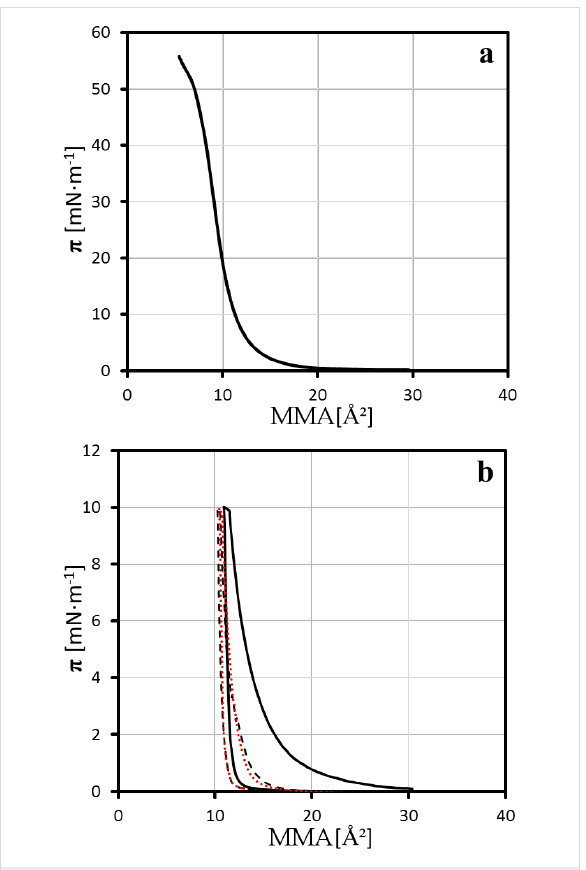
Figure 1: π – A isotherm (a) and compression–expansion curve (b) of PPDL-D4 recorded on water at room temperature. MMA is the mean molecular area per monomer unit. For the compression–expansion curve, the black, dashed-black and red-dotted lines are the first, second and third compression–expansion cycles,